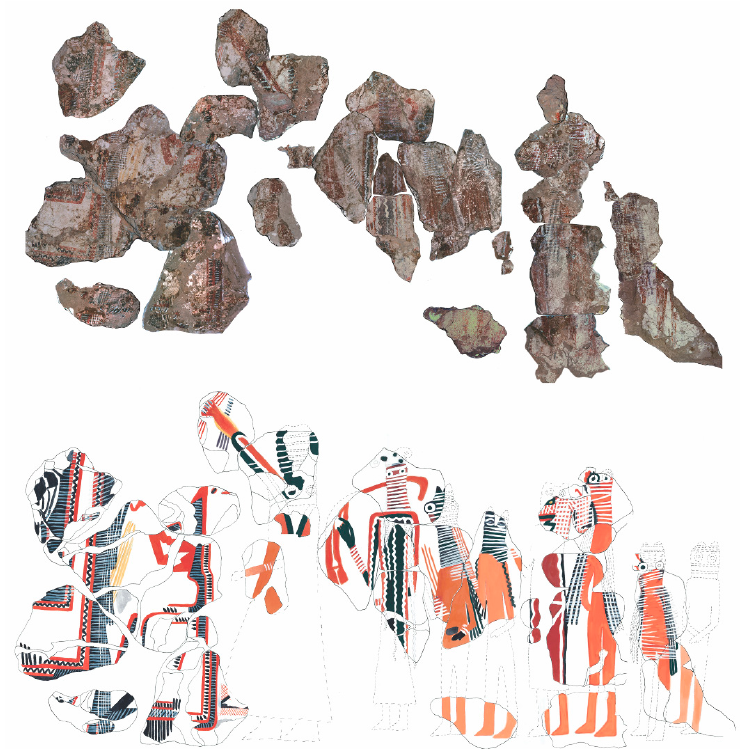
Figure 4. Hennessy’s Processional fresco (created by author).